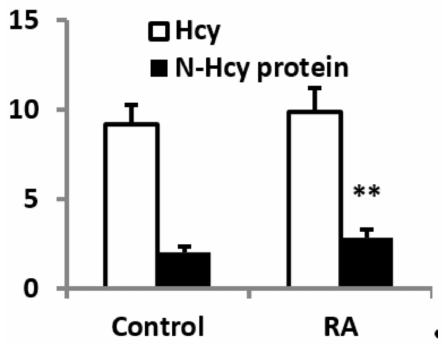
Figure 2. Total serum homocysteine (Hcy) and N-Hcy-protein (both in µ M) in RA patients and control subjects. ** p < 0.01 vs. control